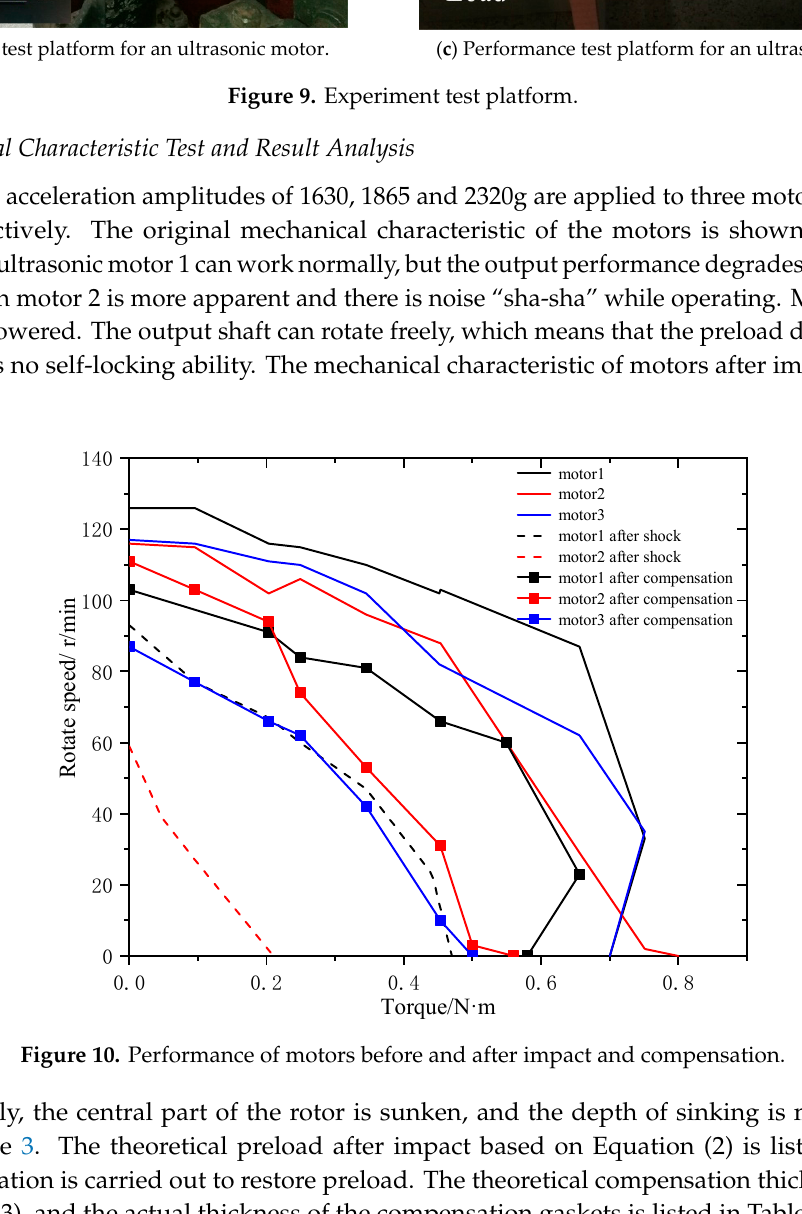
Figure 10. Performance of motors before and after impact and compensation.